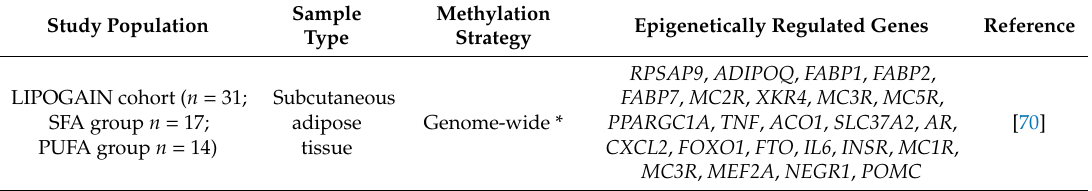
Table 3. Impact of 7 weeks of overfeeding with SFAs or PUFAs on DNA methylation in humans. Sample Study Population